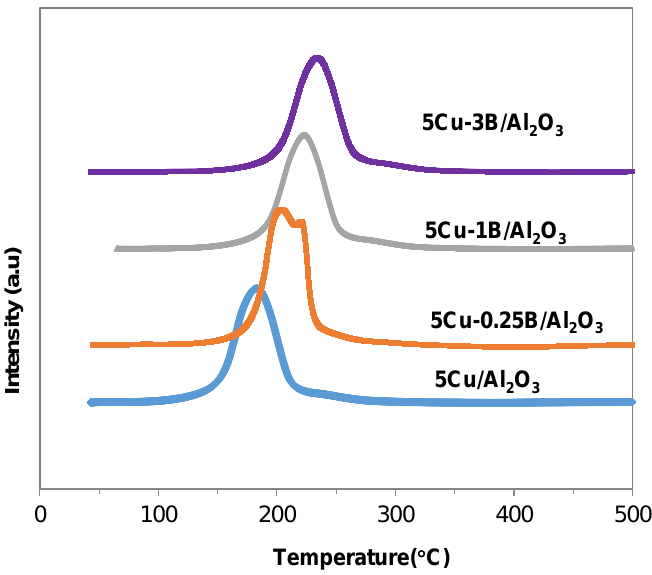
Figure 2. H 2 -TPR profiles of the fresh Cu/Al 2 O 3 catalysts loaded with various amounts of B 2 O 3 .